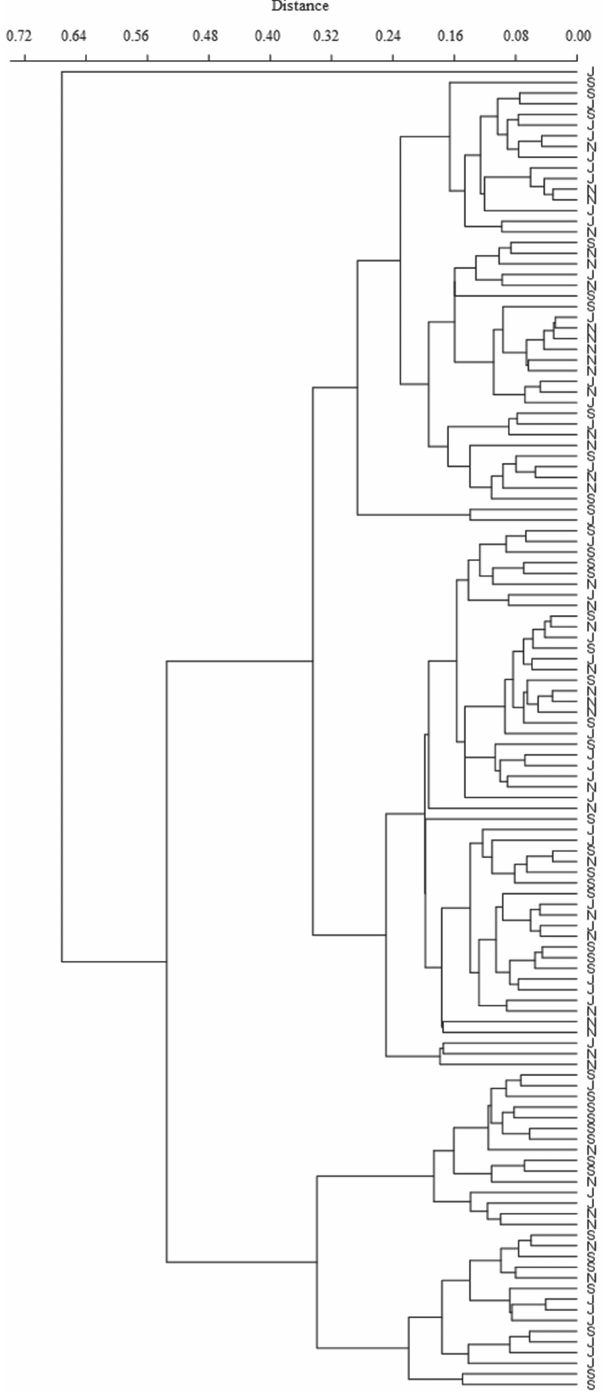
Fig. 3. Cluster analysis based on the euclidean distances of the wavelet functions by shape analysis of asteriscus otoli- ths Prochilodus nigricans between rivers. S (Solimões); J (Japurá) and N P < 0.001). The CVA1-axis (76.8% of variance) separated the otoliths from more elliptic shape to oval or pentagonal shapes; whilst the CVA2-axis (21.2%) differentiated be-